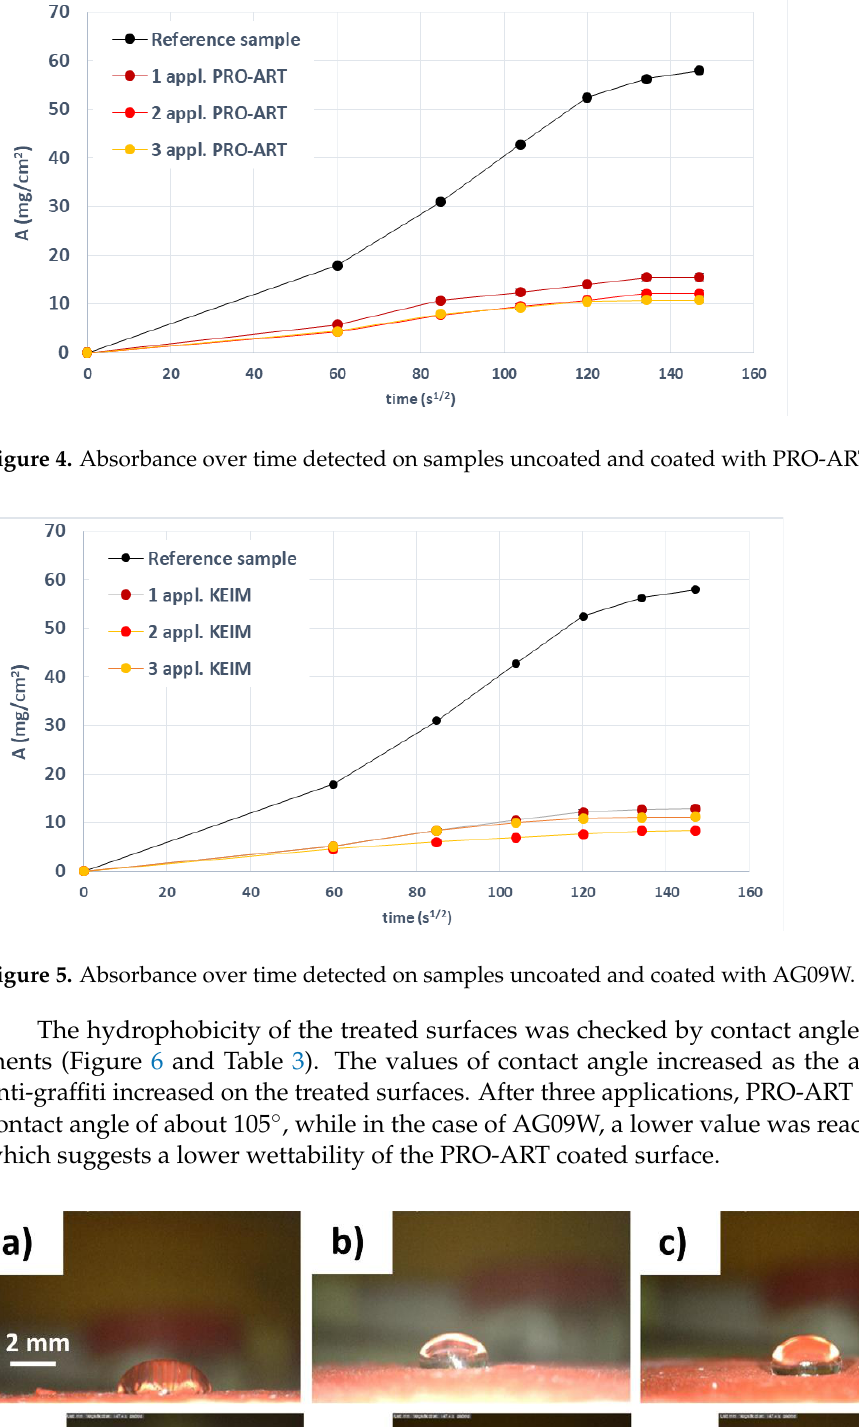
5 of 8 Figure 3. Photographs of samples under UV light: untreated ( a , e ); treated with PRO-ART with ( b ) 1 application, ( c ) 2 applications, and ( d ) 3 applications; and treated with AG09W with ( f ) 1 applica- tion, ( g ) 2 applications, and ( h ) 3 applications .